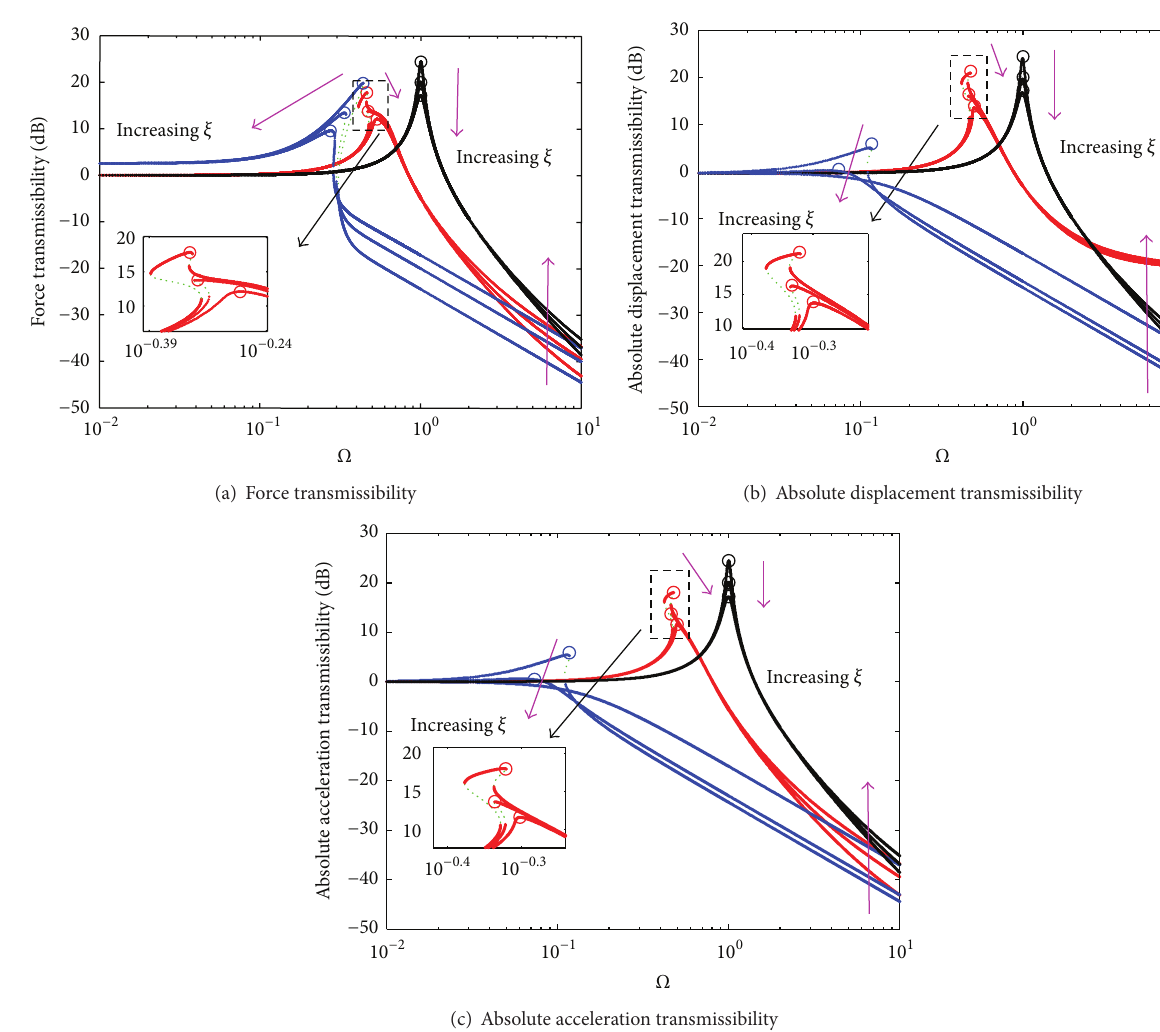
Figure 15: Transmissibilities of the QZS isolator and ELS with different damping ratios ( 𝜉 = 0.03 ; 𝜉 = 0.05 ; 𝜉 = 0.07 ). “Red line” the disturbed isolator; “blue line” the ideal isolator; “black line” ELS; “green dotted line” unstable solutions; “o” peak amplitude of transmissibility; “magenta arrow” increasing damping